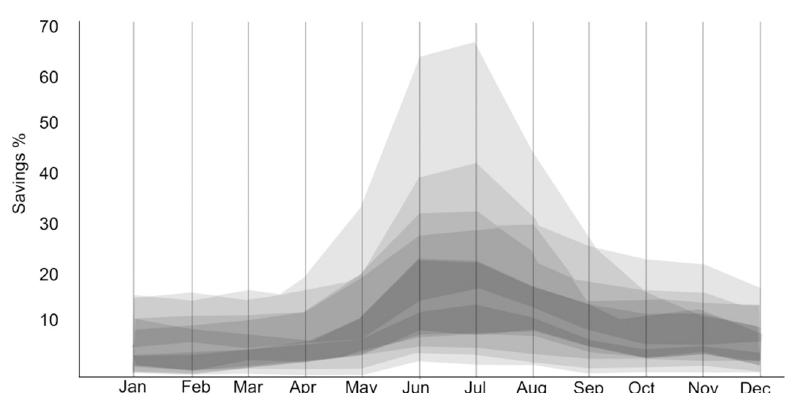
Figure 6. Monthly cooling loads reduction for office spaces (the thermal zones with negative savings have been excluded from this graph). Each grey area represents a thermal zone, and the darker color indicates a higher density of zones within that savings range.